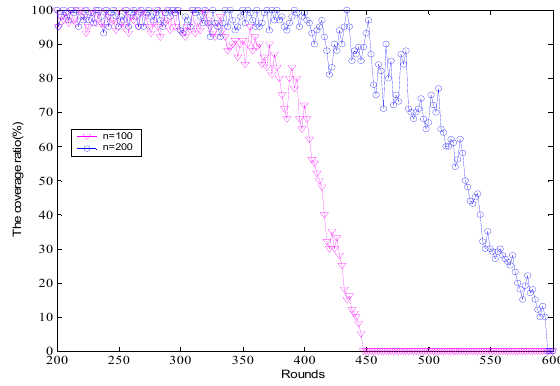
Figure 11. Comparison of the coverage ratio over rounds.